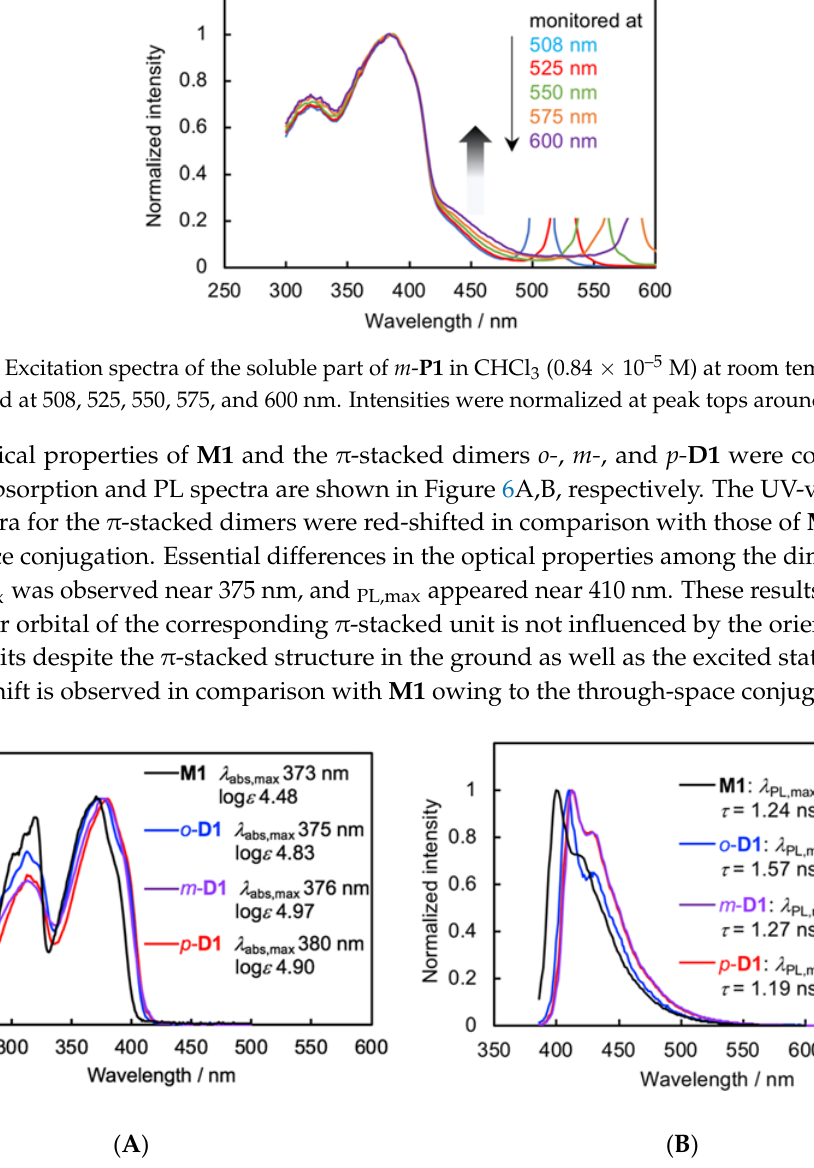
Figure 6. ( A ) UV-vis absorption spectra of M1 , o - D1 , m - D1 , and p - D1 in CHCl 3 (1.0 × 10 –5 M); ( B ) PL spectra of M1 , o - D1 , m - D1 , and p - D1 in CHCl 3 (1.0 × 10 –5 M), excited at each λ abs,max .